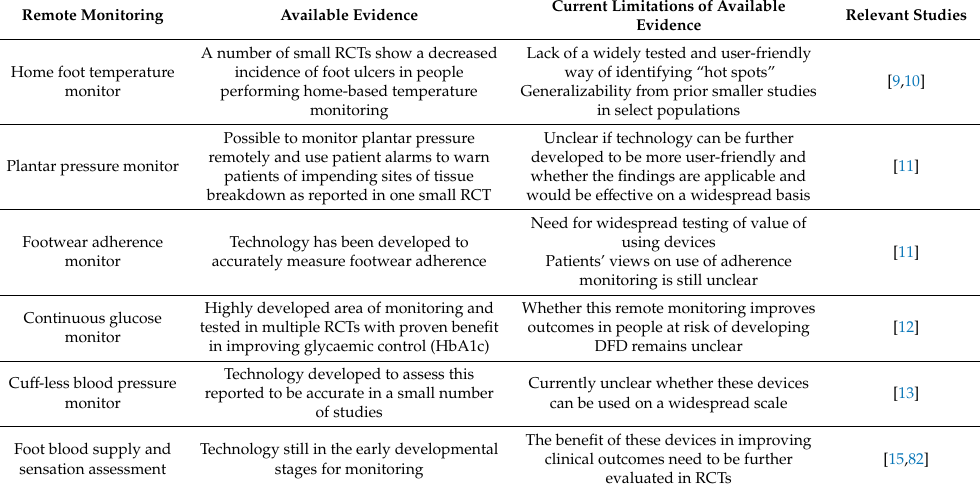
Table 2. Currently available and required evidence for the remote assessment and prevention of diabetes-related foot